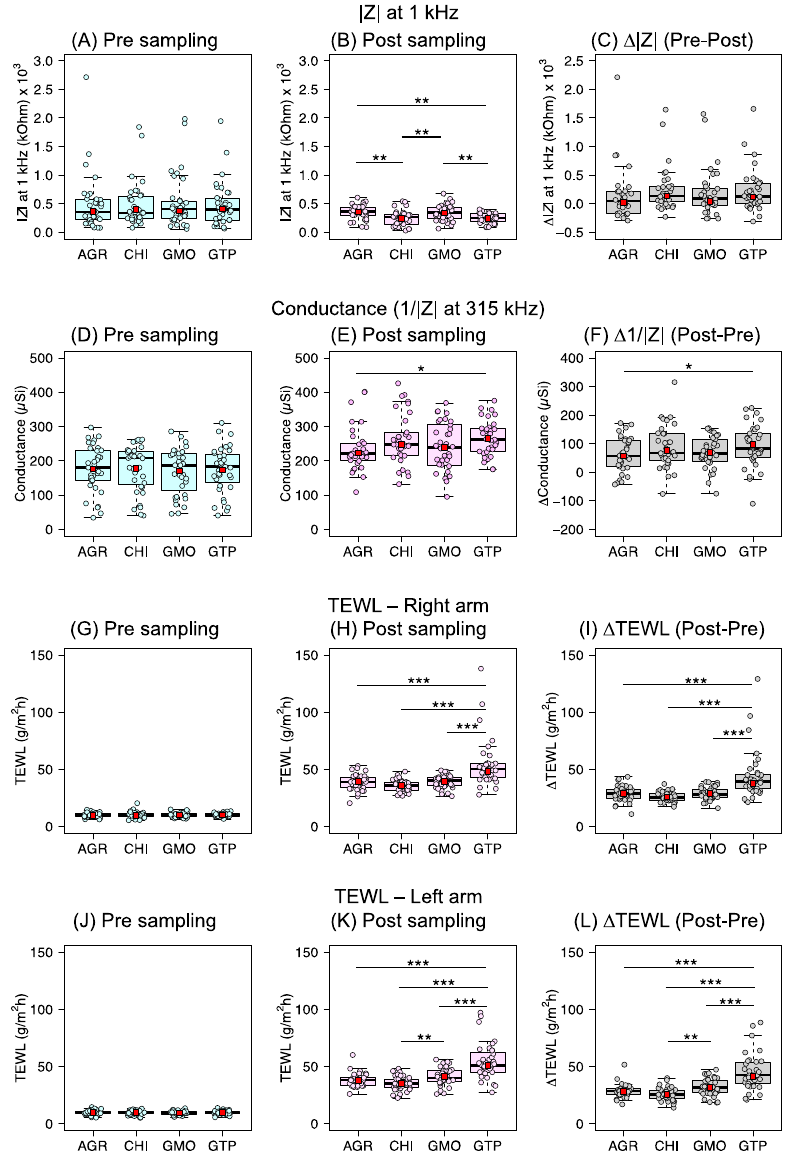
Figure 2. Comparison between pre- (left panel, ( A , D , G , J )) and post- (middle panel, ( B , E , H , K )) skin barrier biophysical data obtained at skin sites grouped according to sampling formulations, including the difference between corresponding pre- and post-data (right panel, ( C , F , I , L )). Skin resistance values represent |Z| at 1 kHz, and conductance values represent 1/|Z| at 315 kHz. The significance levels used were: * p < 0.05, ** p < 0.01, *** p < 0.001. See Table S4 for a compilation of p -values